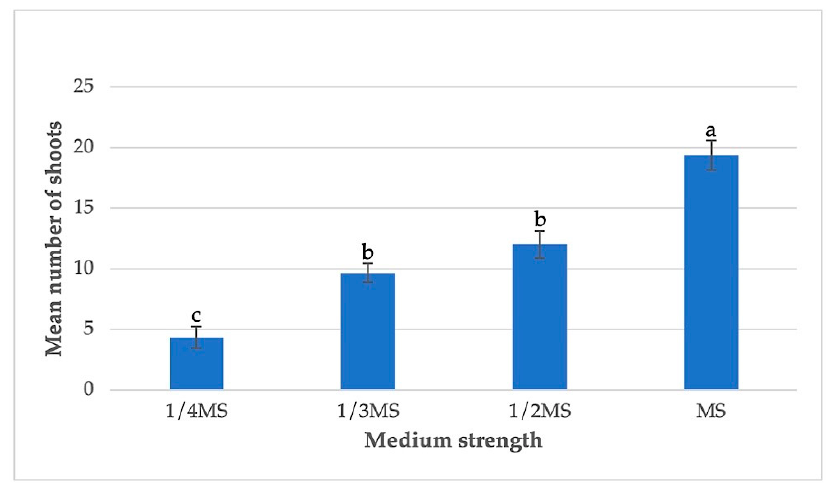
Figure 2. Effect of MS medium strength with optimized concentration of 6-benzyladenine (BA) on shoot regeneration from axillary node explants of Plectranthus amboinicus . Data are expressed as mean ± SE recorded after 8 weeks of culture on shoot induction medium. Bars denoted with different letters indicate significant differences among treatments according to Tukey’s honestly significant difference test (Tukey’s HSD) at a p -value of less than 0.05.